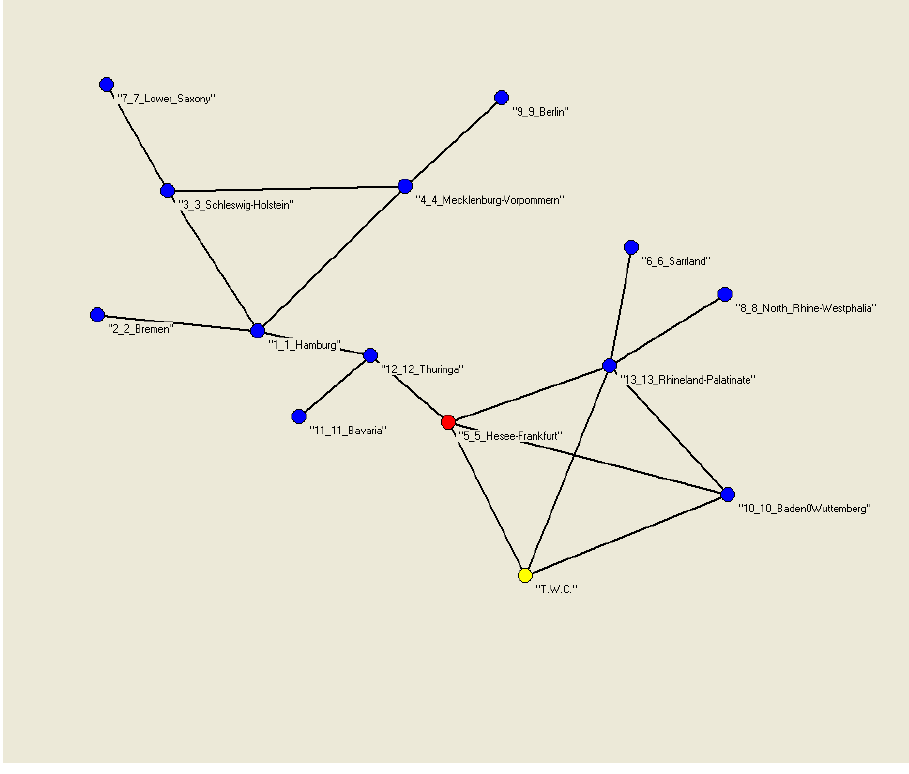
Figure 18. The M.R.G of the paths found using the TWC- γ